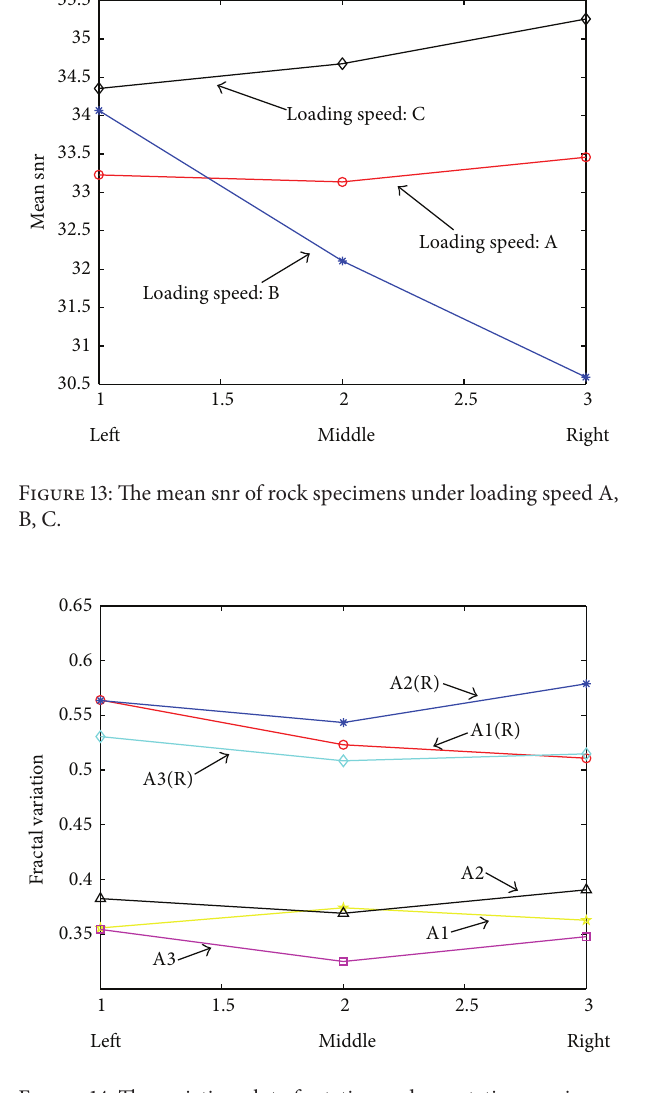
Figure 14: The variation plot of rotation and no rotation specimens under loading rate A.